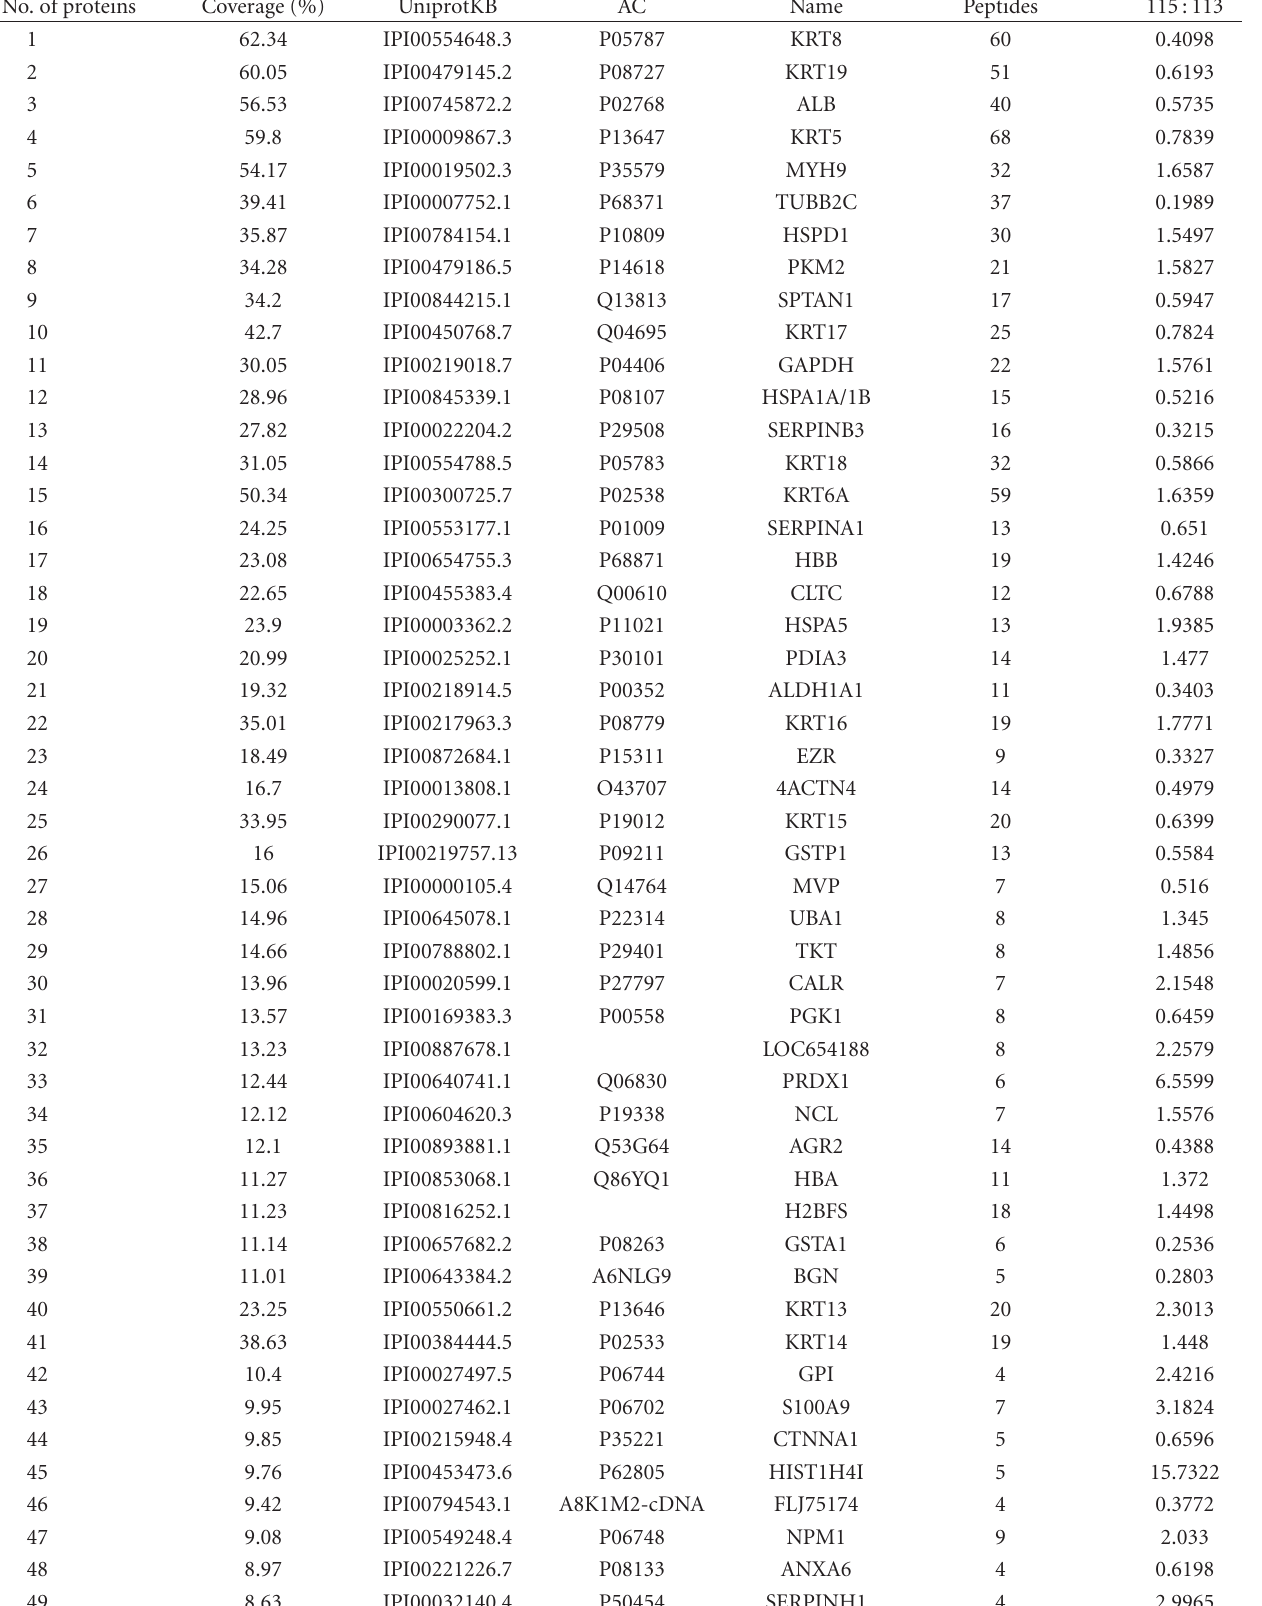
Table 2: Di ff erential expressed proteins in LCM-purified HLSC and NHBE identified by mass